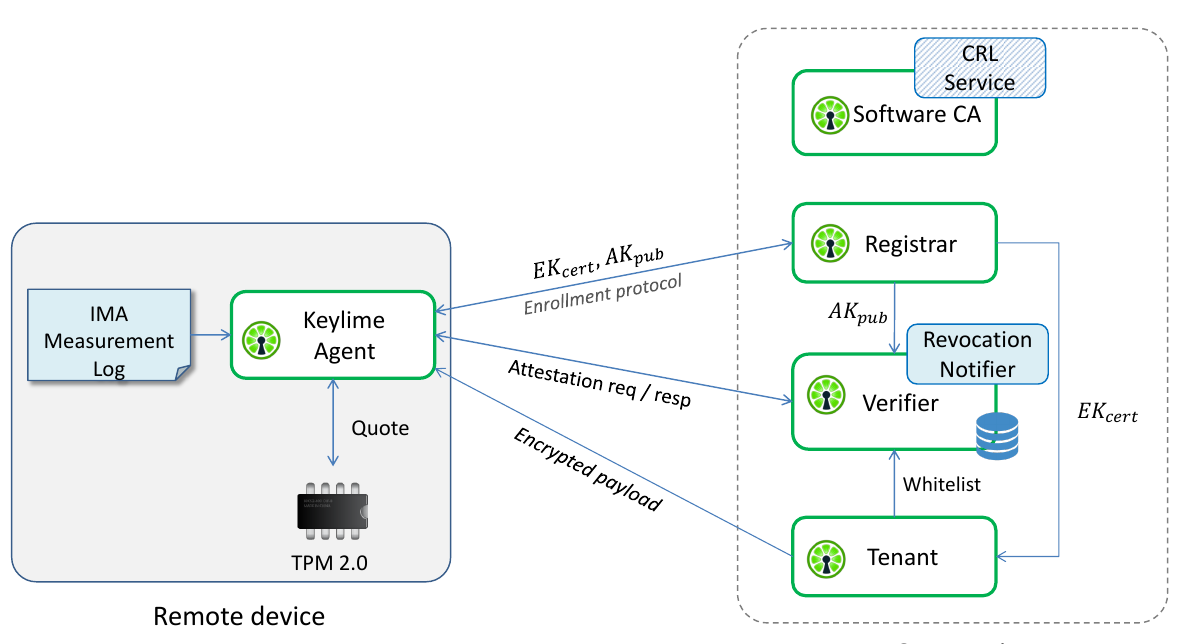
Figure 8. Simplified architecture of the Keylime